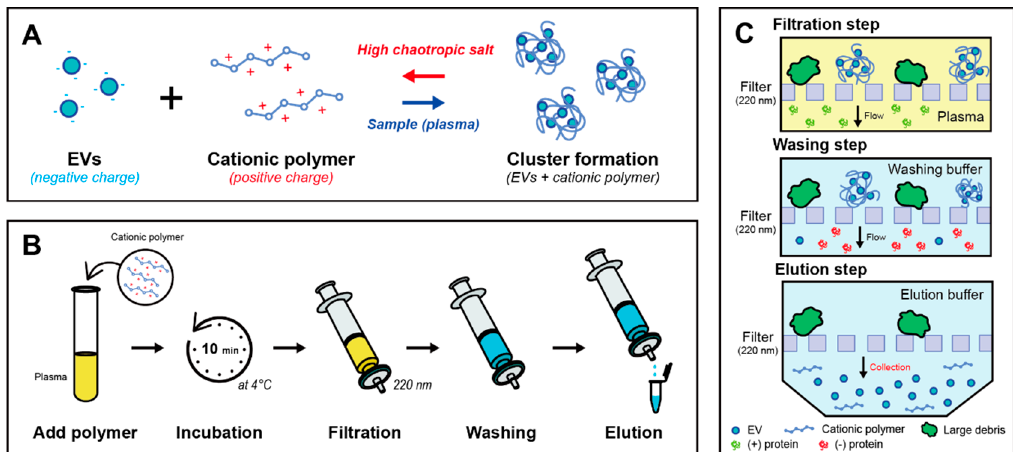
Figure 1. Schematic illustration of PLL-clustering method for extracellular vesicle isolation. ( A ) Cluster formation by adding cationic polymer (PLL) in plasma sample and scattering EVs in elution buffer with chaotropic salt. ( B ) Experimental procedure to isolate EVs from plasma sample using a syringe and a filter. ( C ) Simple filtration, washing, and elution steps for EV isolation.